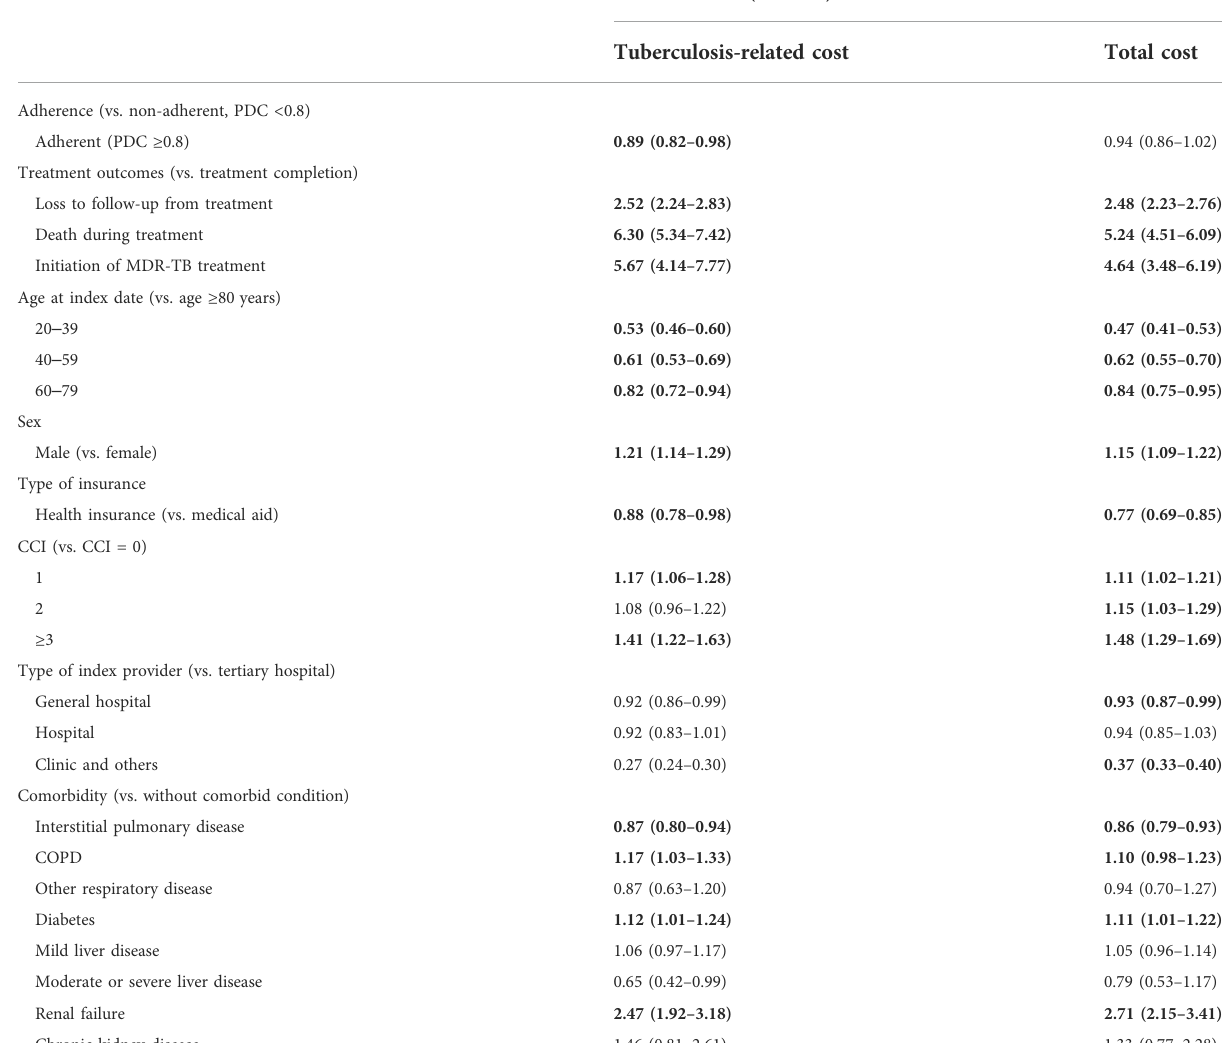
TABLE 3 Factors associated with the monthly cost per patient.